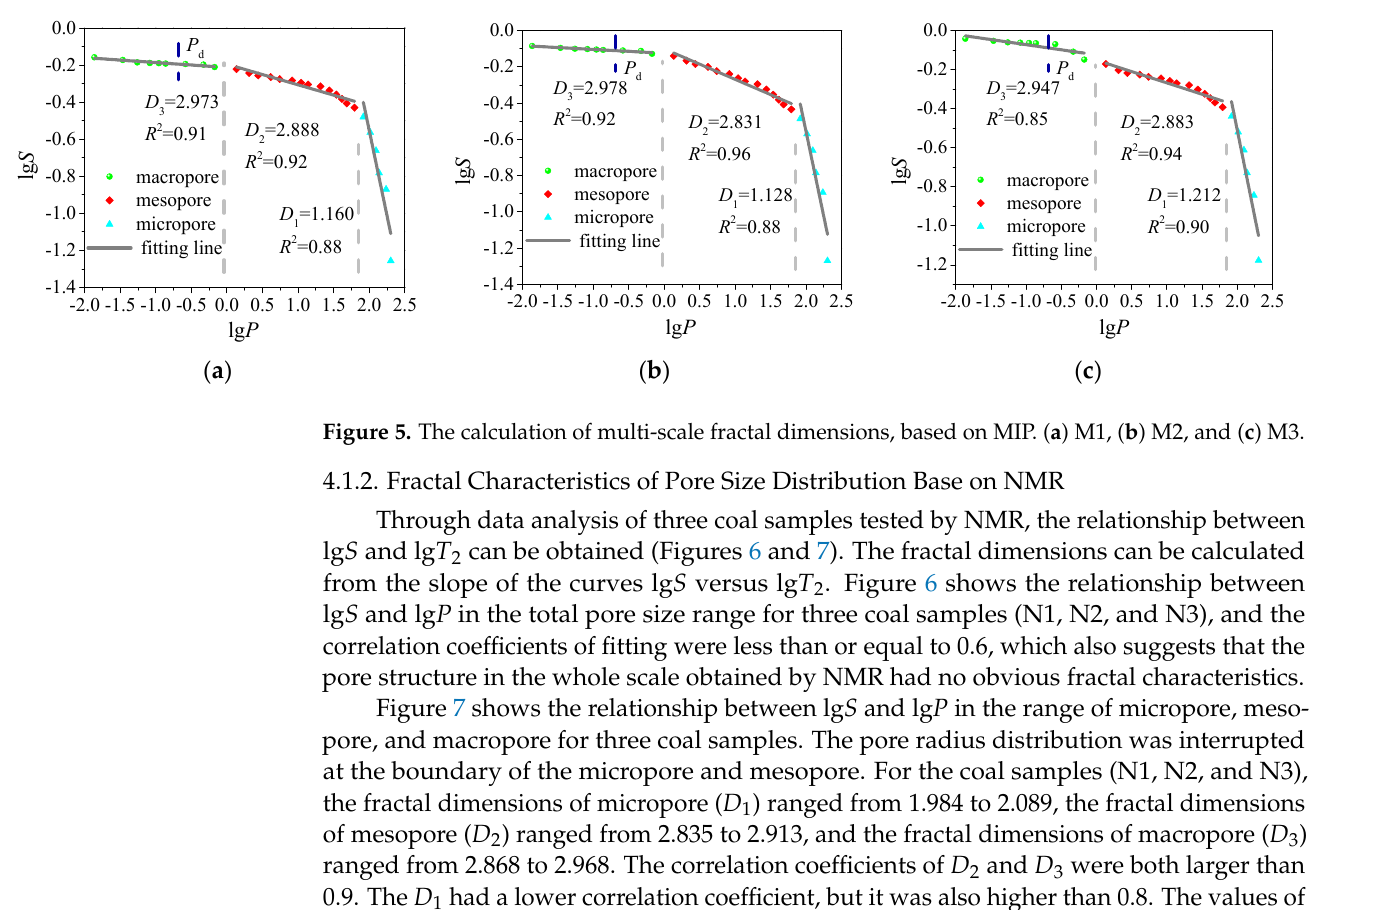
Figure 4. Log–log fitting results for the entire pore size range, based on MIP. ( a ) M1, ( b ) M2, and ( c ) M3.